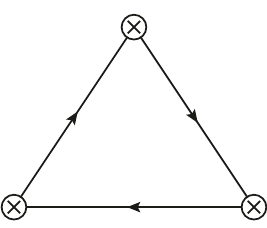
Figure 3. Feynman diagram of the perturbative contribution to the three-point Green functions at the leading order. The addition of the Bose-symmetrized diagram is tacitly assumed. Bose- symmetrized contribution can be obtained by reverting the direction of the fermionic (cid:13)ow while keeping the position of the inserted currents